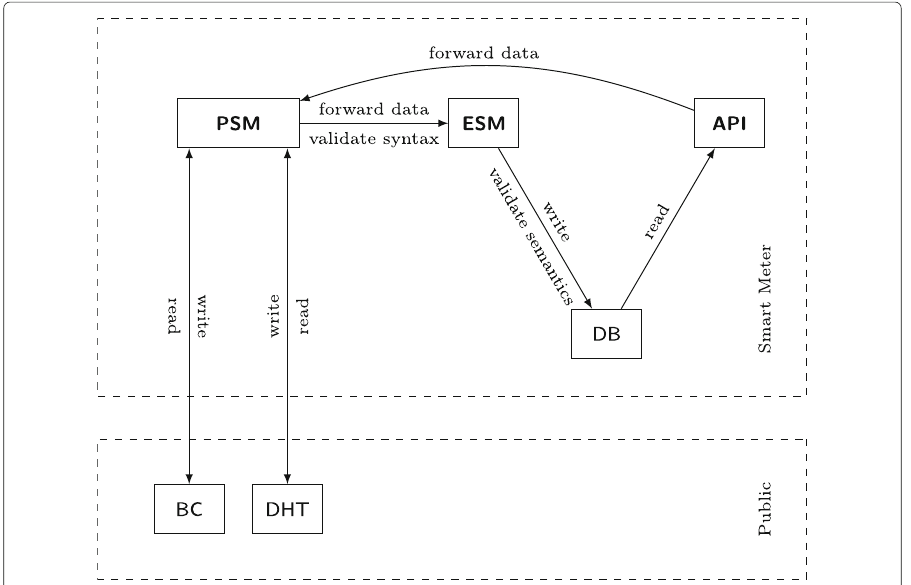
Fig. 4 The prototypical implementation consists of three main modules: The PSM communicates with the Blockchain (BC) and a distributed hash table (DHT). Syntactically correct data is forwarded to the ESM, which validates the semantics, updates the current internal state and stores the new state in a local database (DB). The API allows to read data from the DB and to send data to the PSM for publishing new events to the BC and the DFS, respectively. While BC and DHT store data publicly, the rest of the modules is deployed on the smart